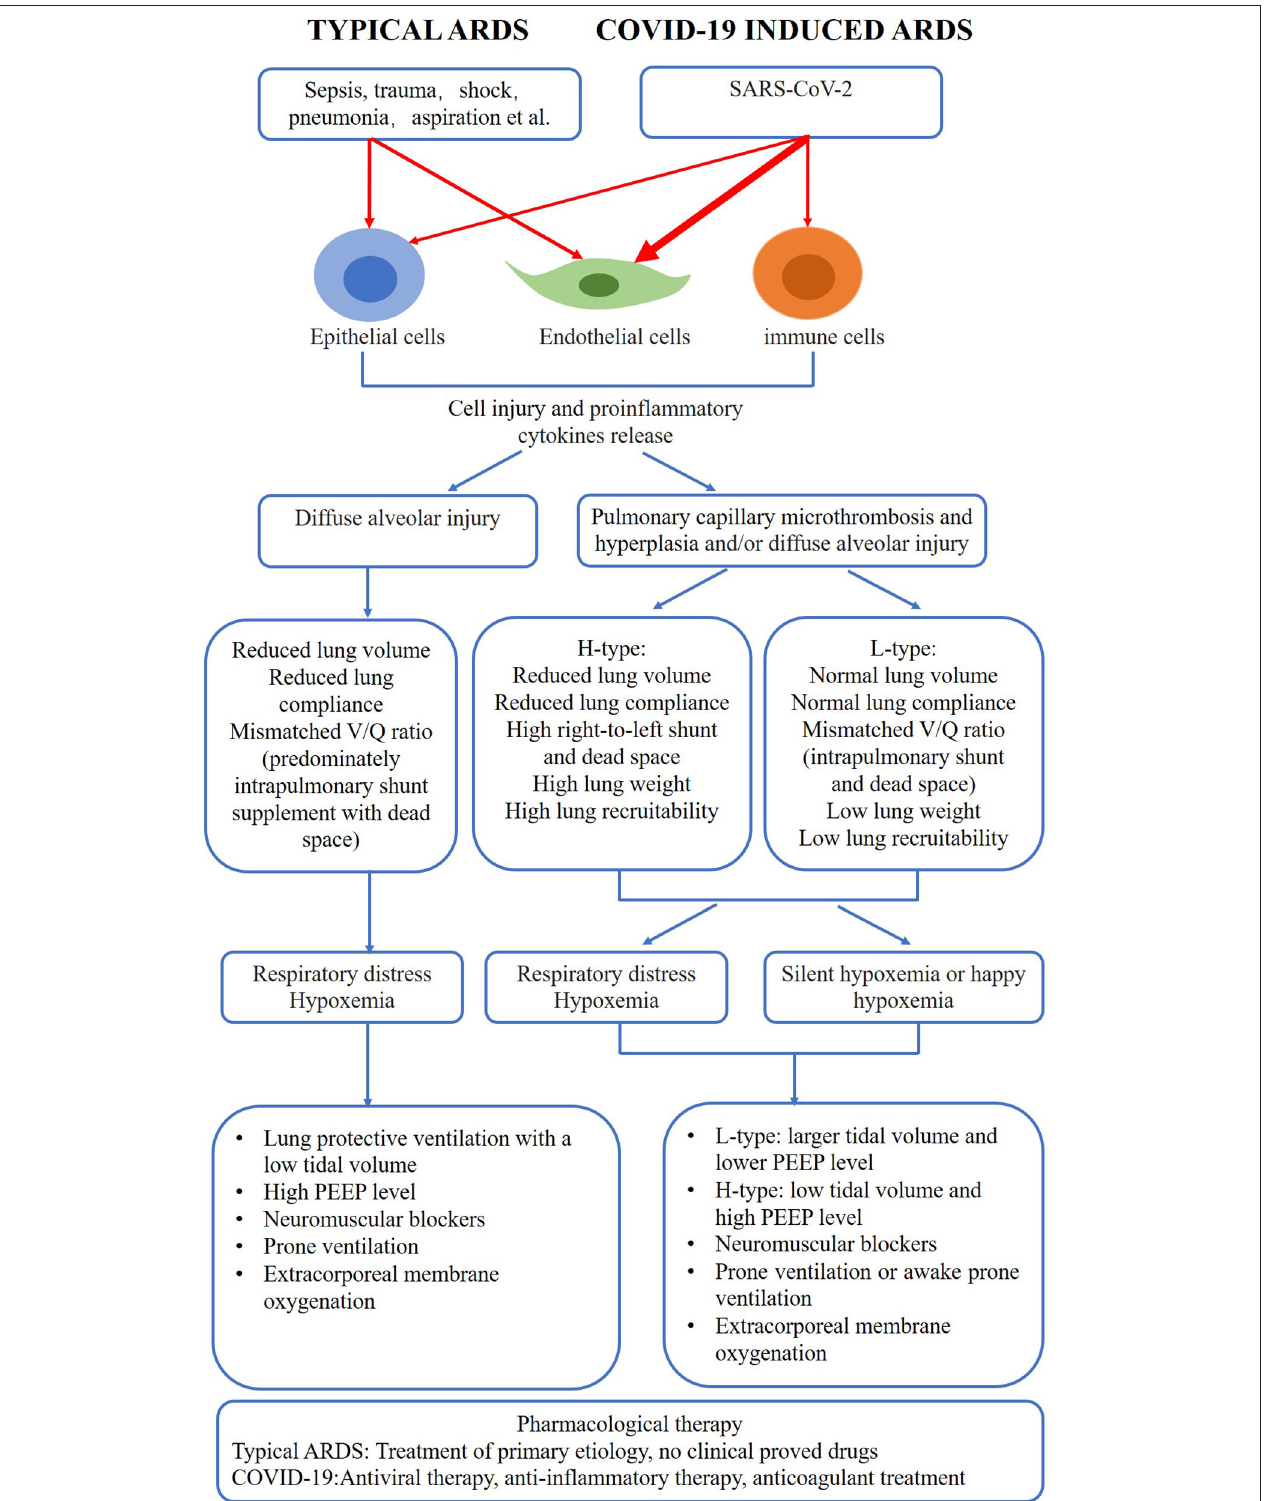
FIGURE 1 | Comparison of COVID-19 induced respiratory failure and typical ARDS. COVID-19, coronavirus disease 2019; ARDS, acute respiratory distress syndrome.